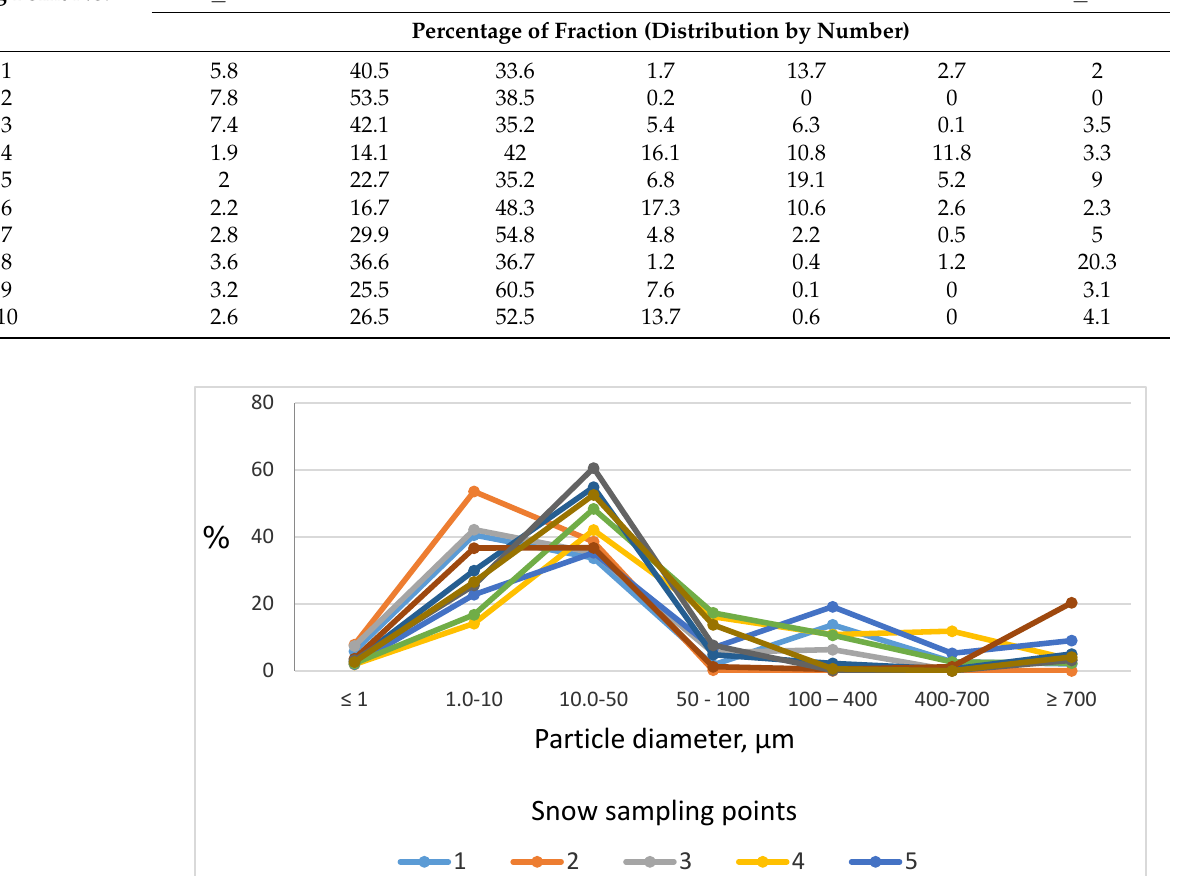
Table 2. Particle size distribution (in %) of particulate matter measured in melted snow samples from Dalnegorsk town. Sampling Point No.